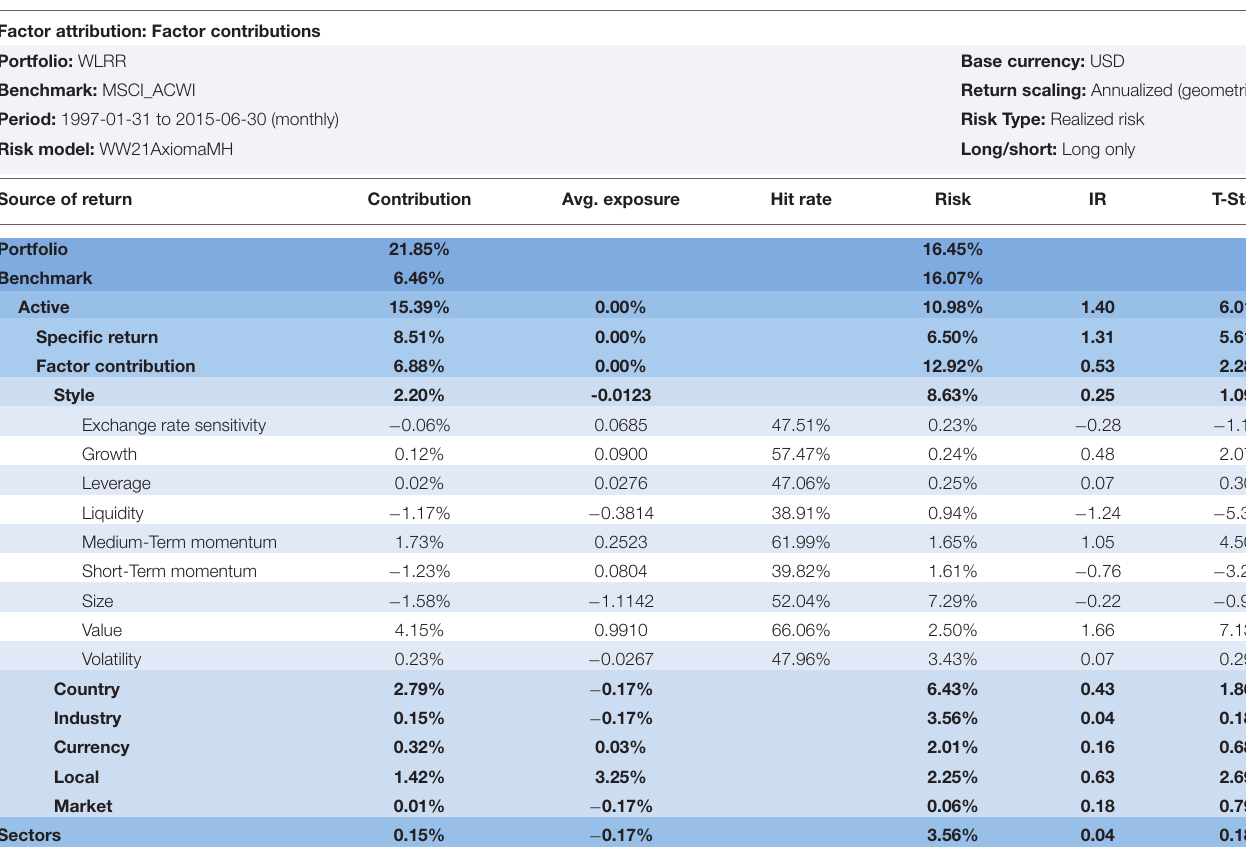
TABLE 5 | Robust regression with